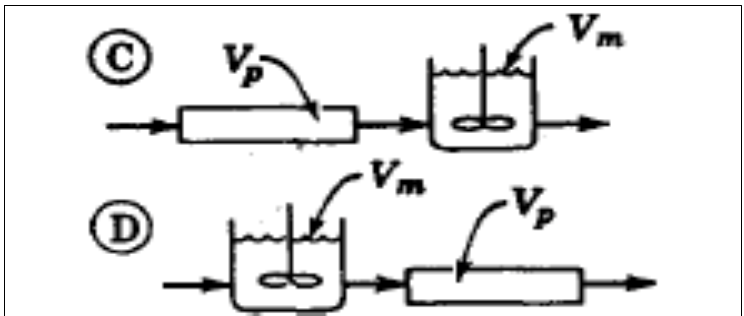
Figure 5: Ideal flow model proposed by Levenspiel. Source: [13].